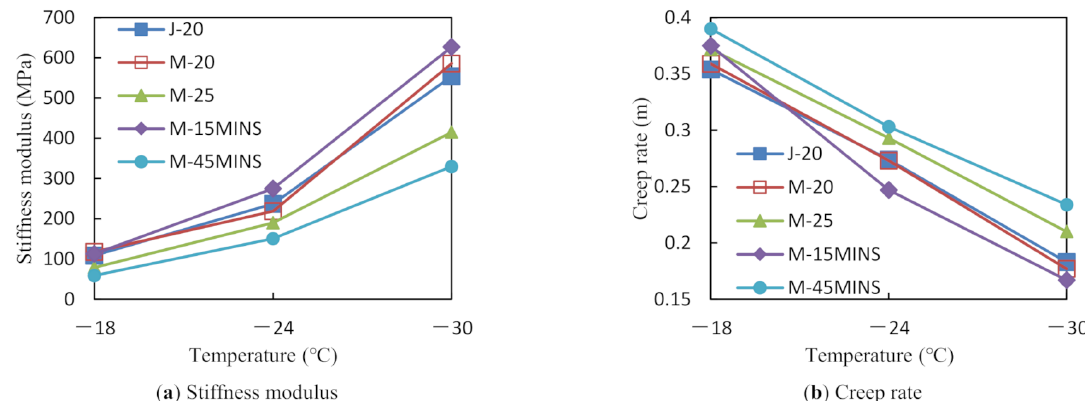
Figure 2. Bending beam rheometer (BBR) test results.